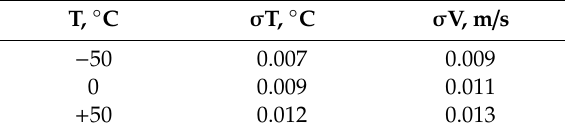
Table 1. Threshold sensitivity of measurements of temperature and wind